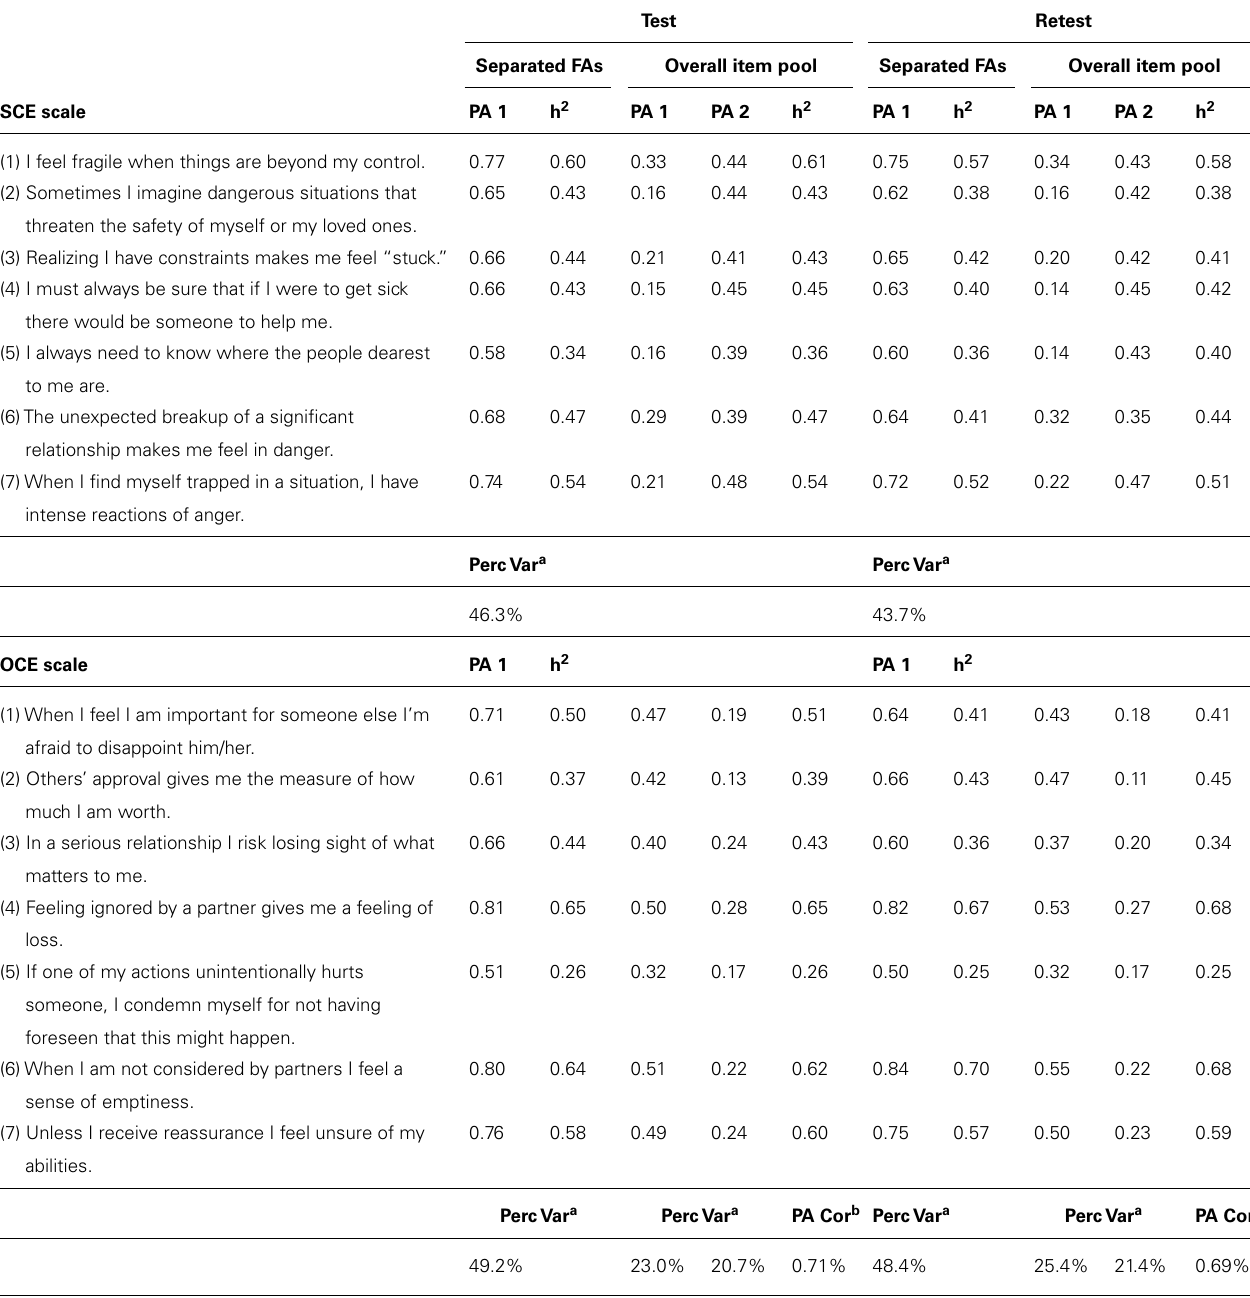
Table 2 | Item factor analysis for the SCE and OCE